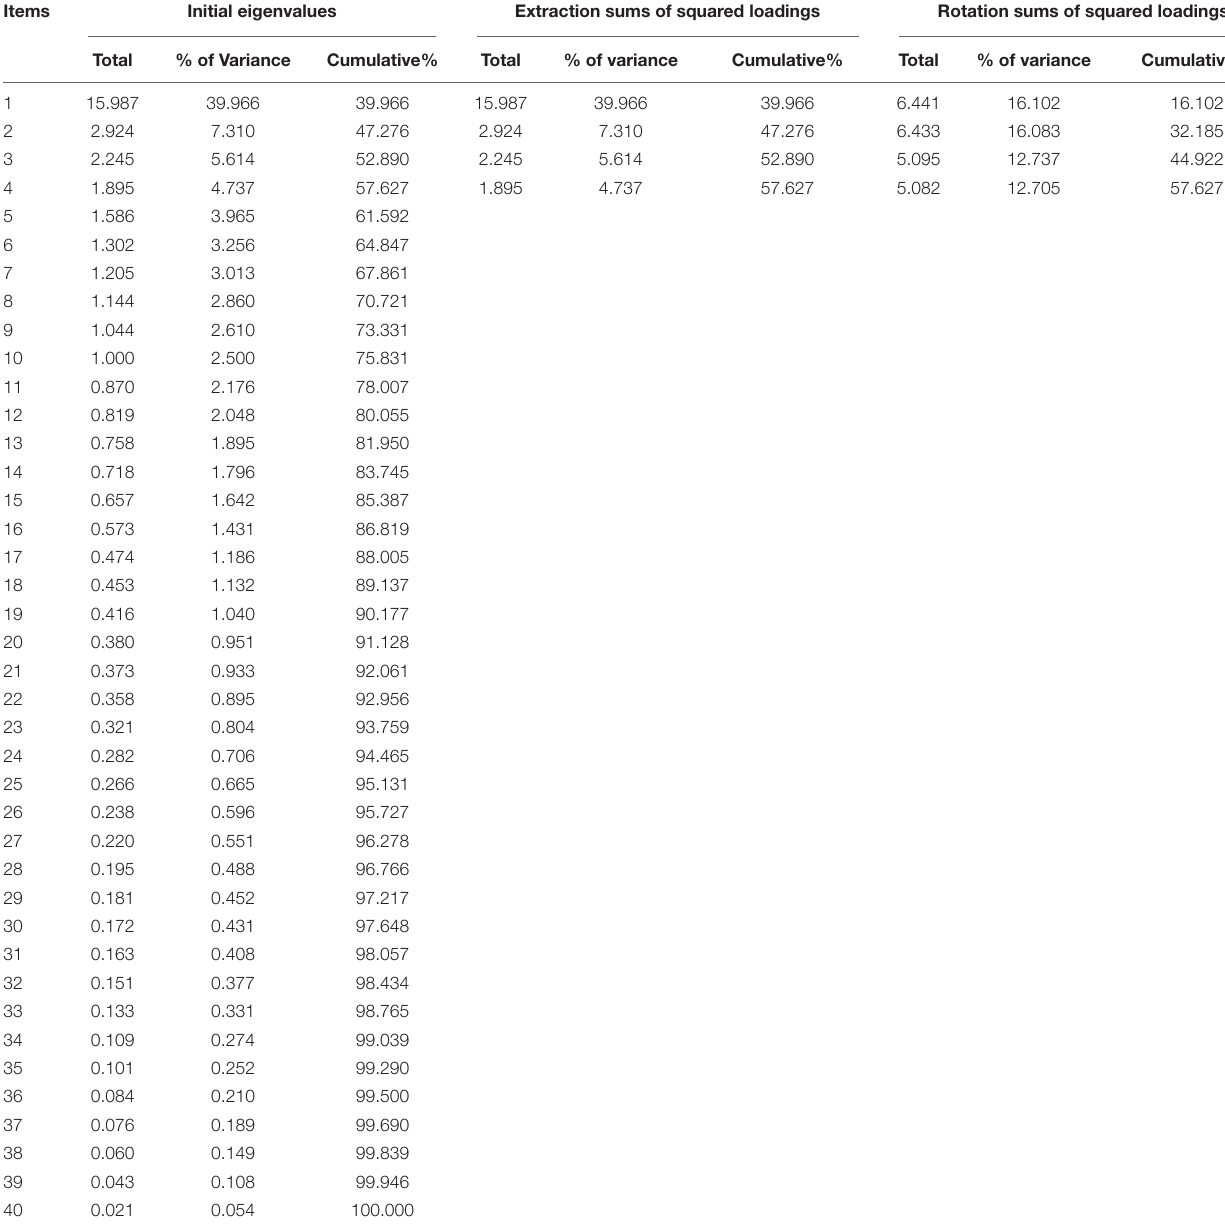
TABLE 3 | Total variance